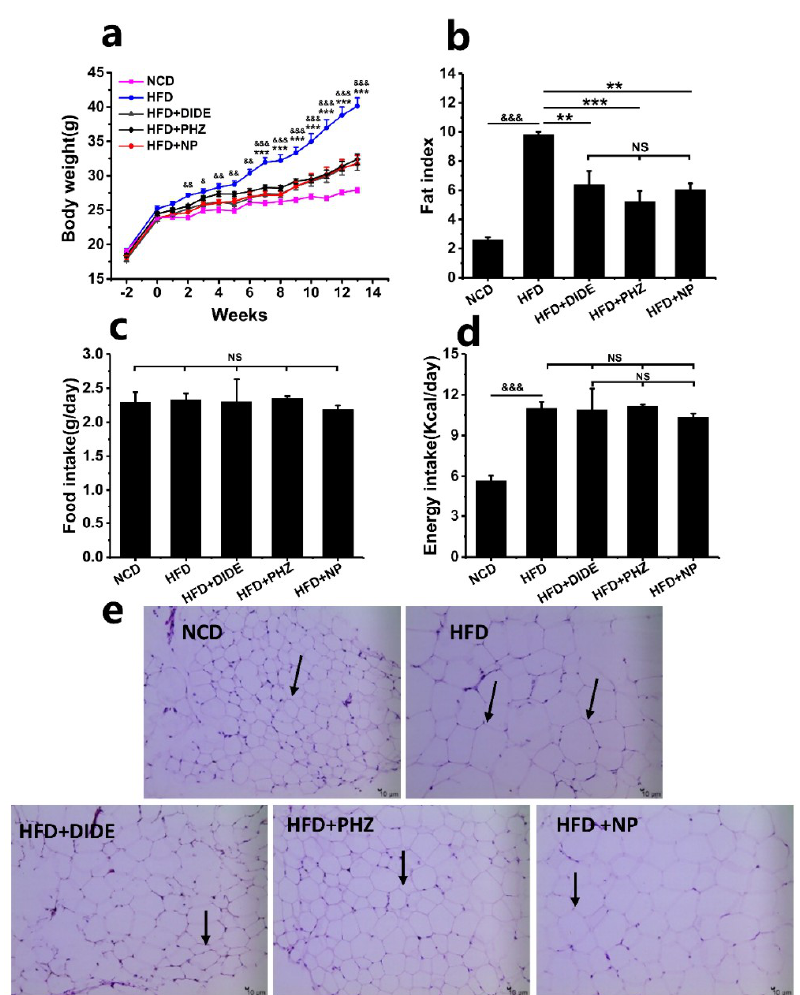
Figure 2 . Effects of DIDE, PHZ, and NP on body weight, fat index, food and energy intake, and